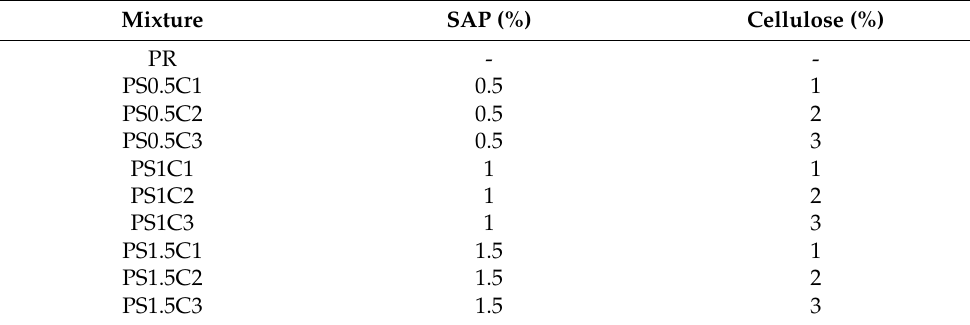
Figure 2. SEM image of cellulose fiber. Table 1. Composition of the studied plasters.